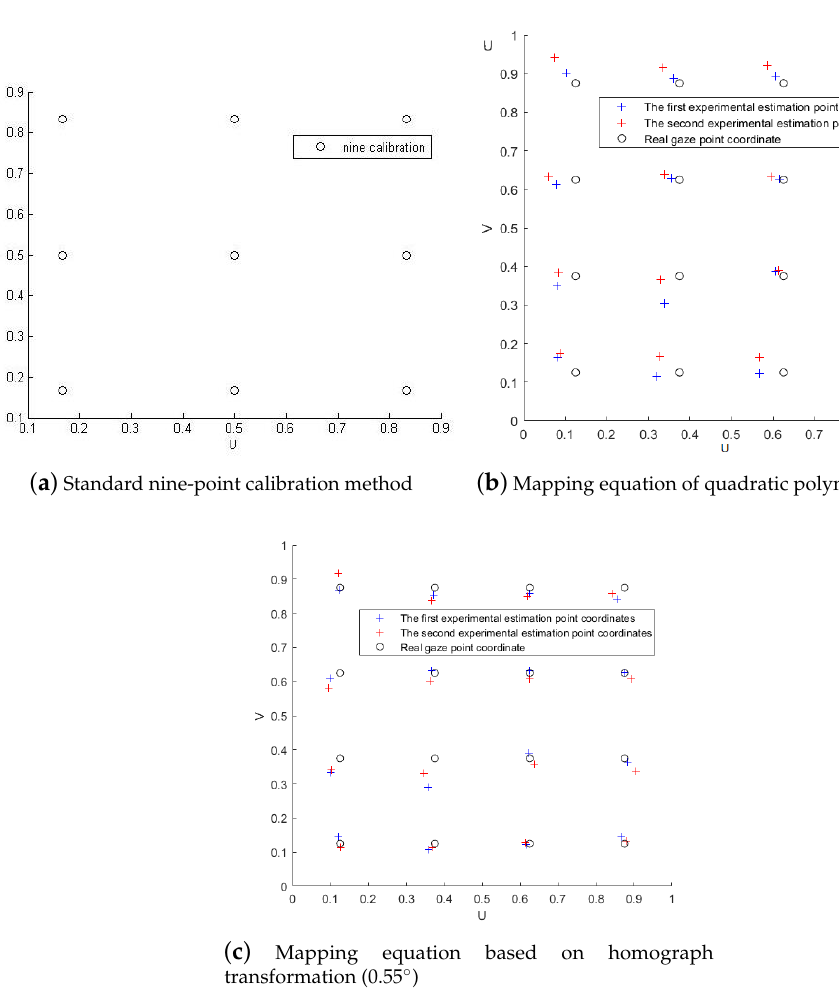
Figure 8. Comparative experimental results of the two methods.